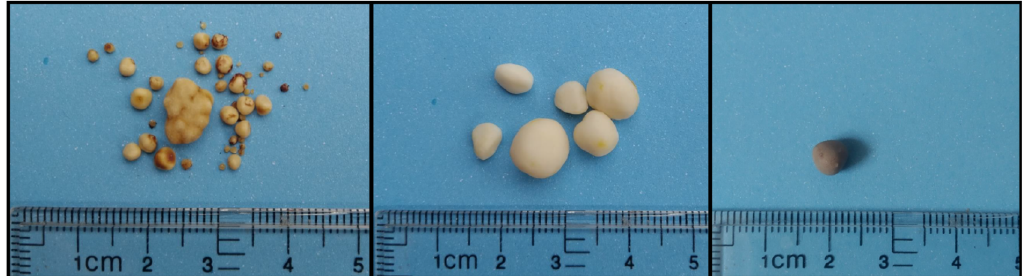
Figure 2. Various canine cystine uroliths obtained via cystotomy. They are usually small, round or ovoid, and light yellow to yellowish brown, tan or reddish brown color.